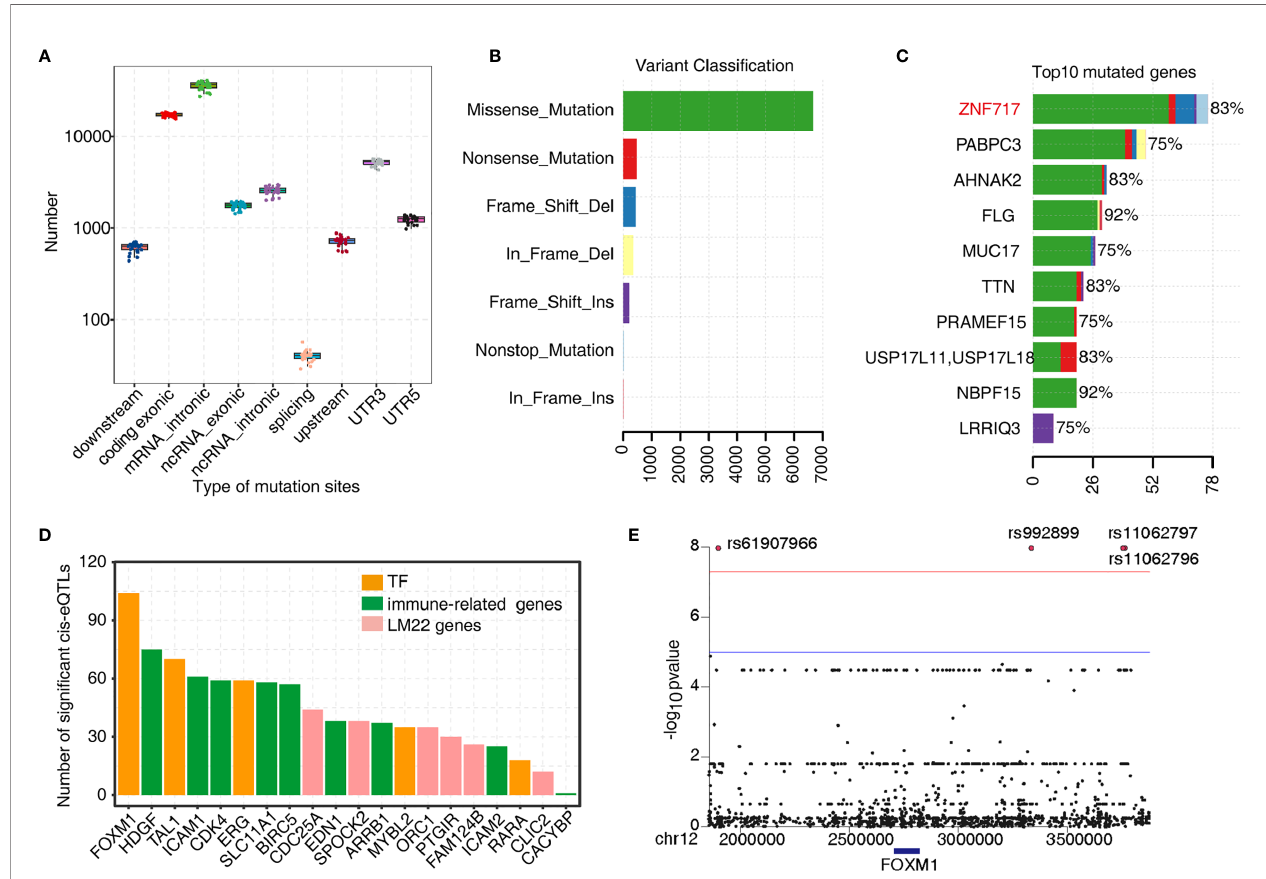
FIGURE 5 | Analysis of the tumor somatic mutations in the TF – immune-related gene expression network. (A) Boxplot showing the relative abundance of SNVs found at different genomic locations. (B) Variant classi fi cation in the 24 samples. (C) Bar plot showing the top 10 mutant genes by the mutation number. (D) Barplot showing the number of signi fi cant cis-eQTLs of each gene from the TF – immune-related gene expression network of MEyellow and MEblue and was used to evaluate the mutation effects on TFs expression. (E) Manhattan plot of the cis-eQTL analysis of